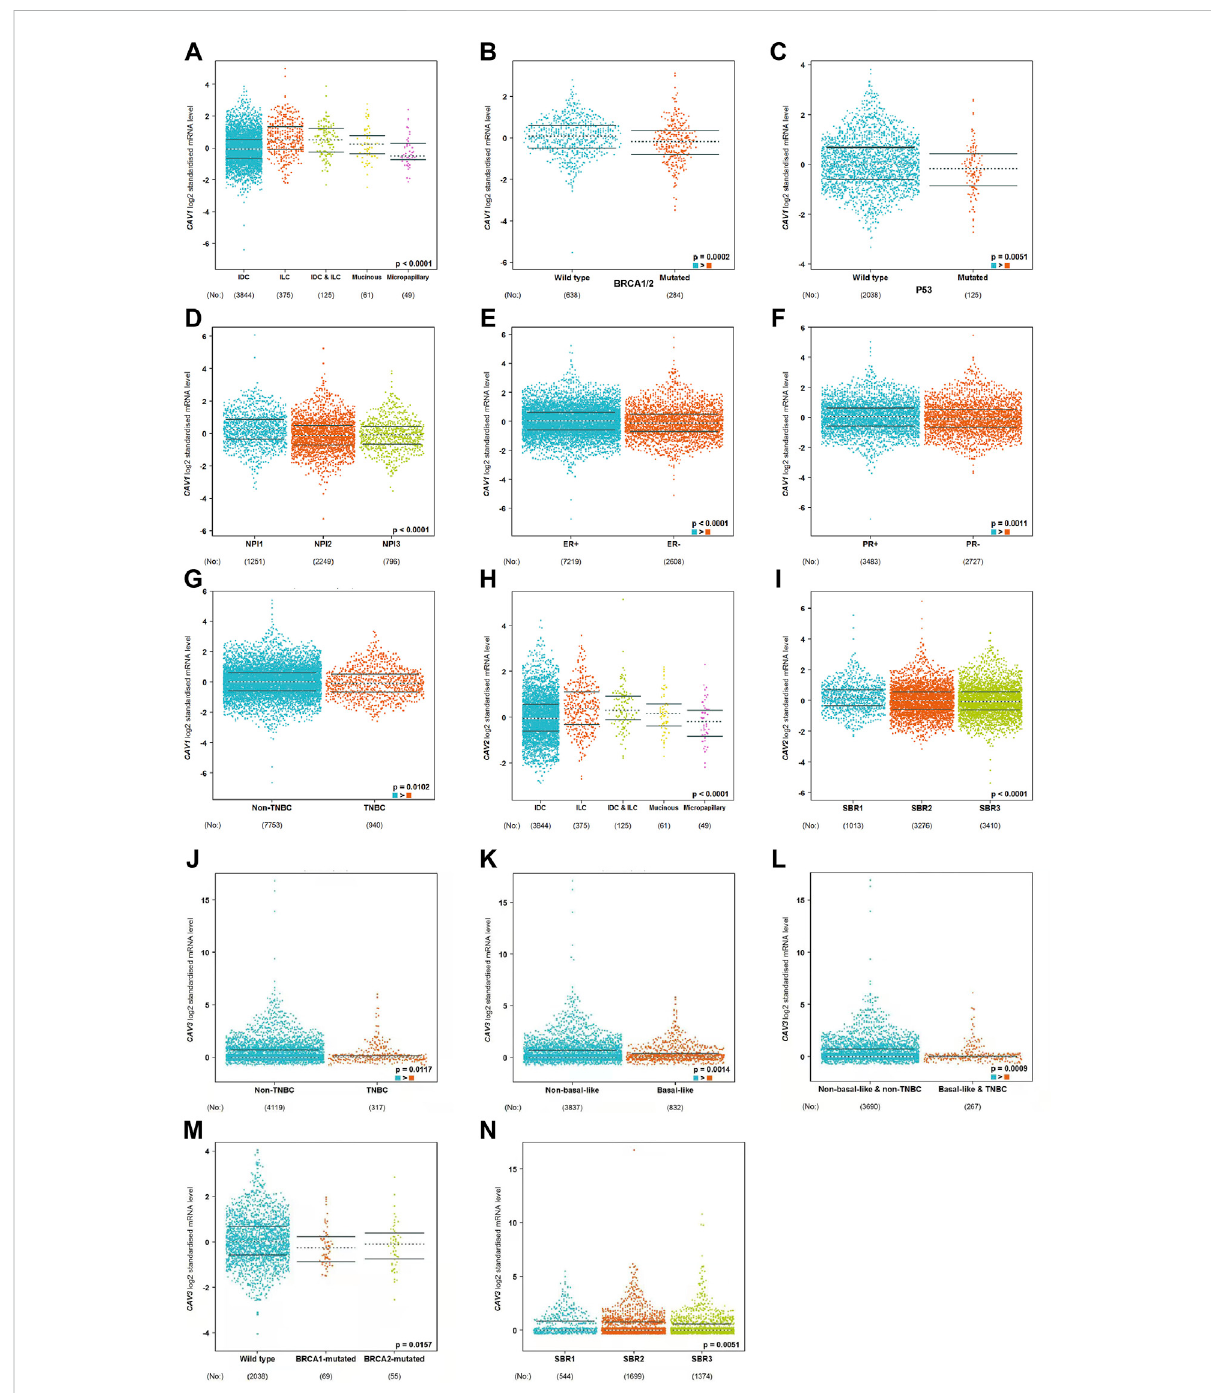
FIGURE 2 (A – N) Analysis of the relationship between CAV expression and the clinicopathologic parameters in BC according to the bc-GenExMiner v4.8 database (http://bcgenex.ico.unicancer.fr/BC-GEM/GEM-Accueil.php?js=1).